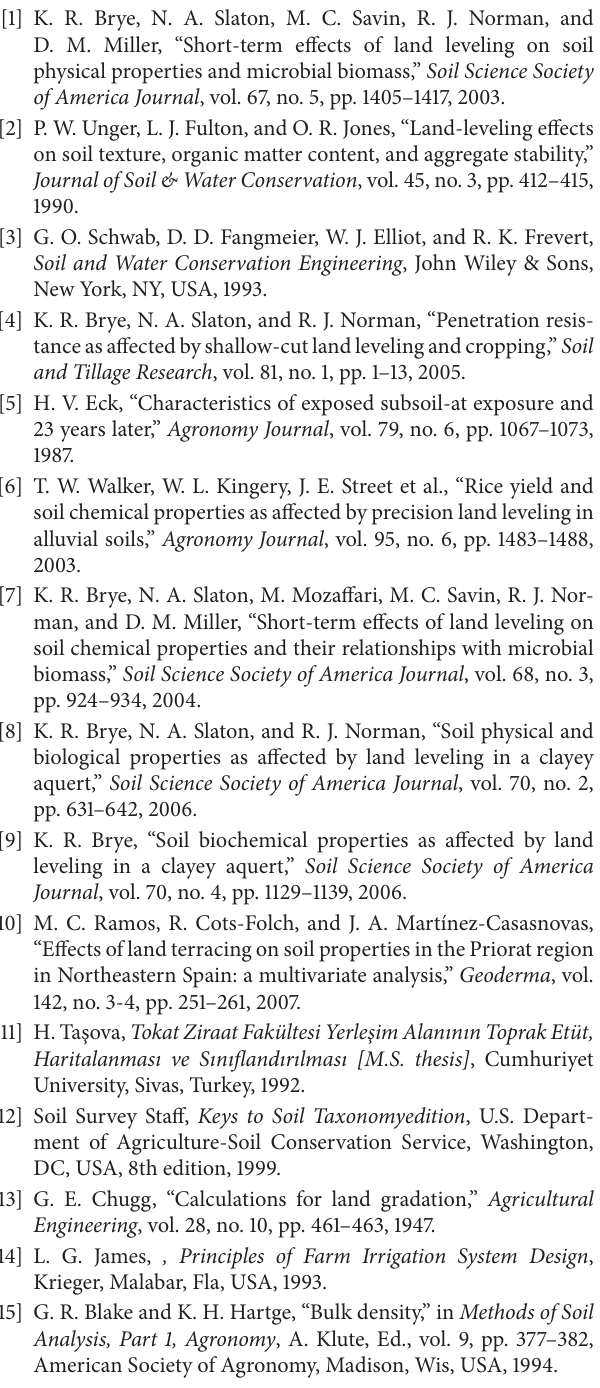
Table 5: Mean changes in surface and subsurface soil properties of cut and fill areas separately that occurred as a result of land leveling. Area Soil depth (cm) WHC (mm) Cut